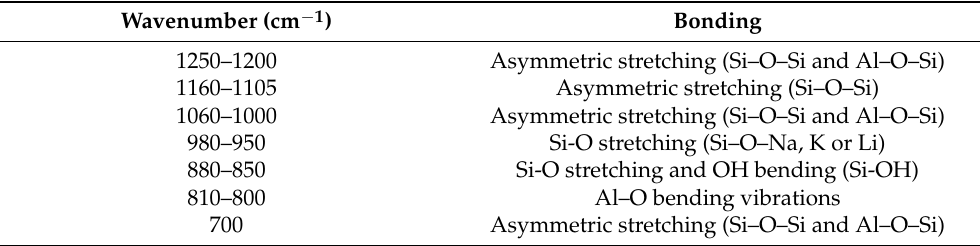
Table 2. Characteristic infrared stretching vibrational bands of a metakaolin-based